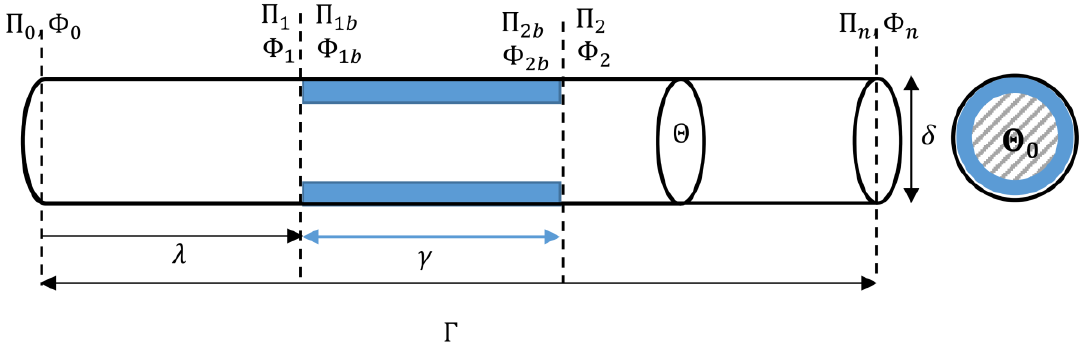
Figure 2. Blockage in the pipeline.